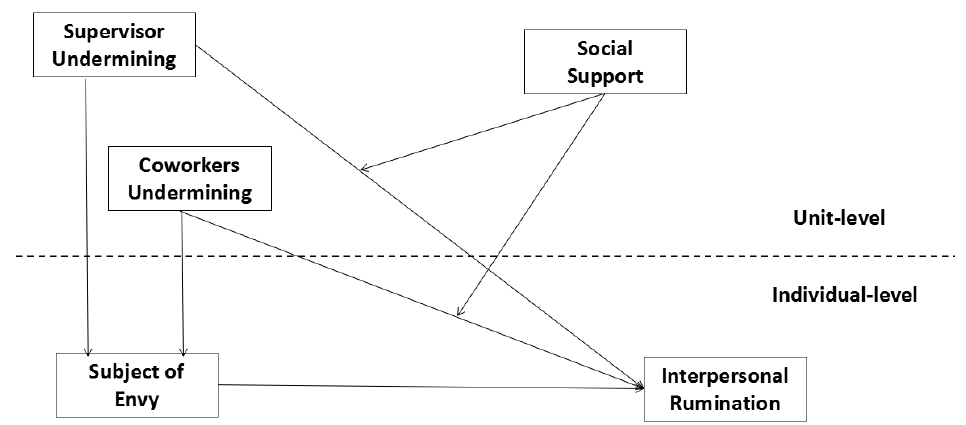
Figure 1. Hypothetical model.